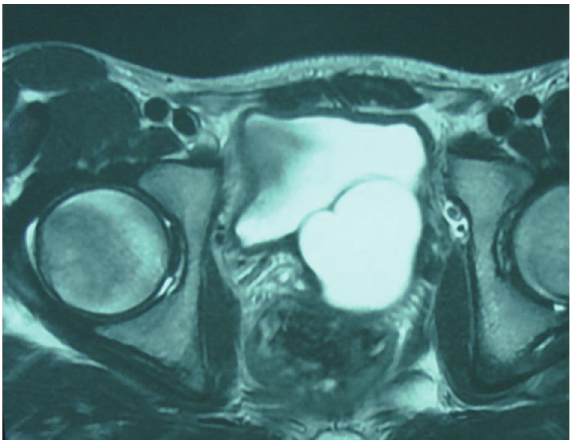
Figure 1: Pelvic MRI showing a seminal vesicle cyst.